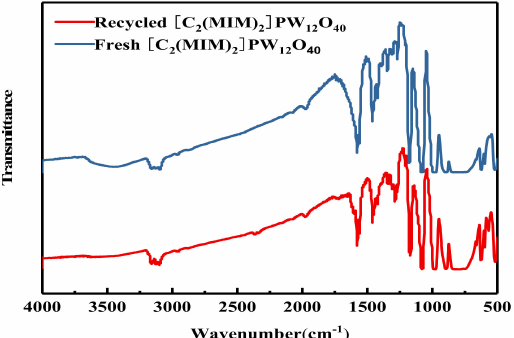
Figure 11. FT-IR spectra of fresh and recycled [C 2 (MIM) 2 ]PW 12 O 40 .